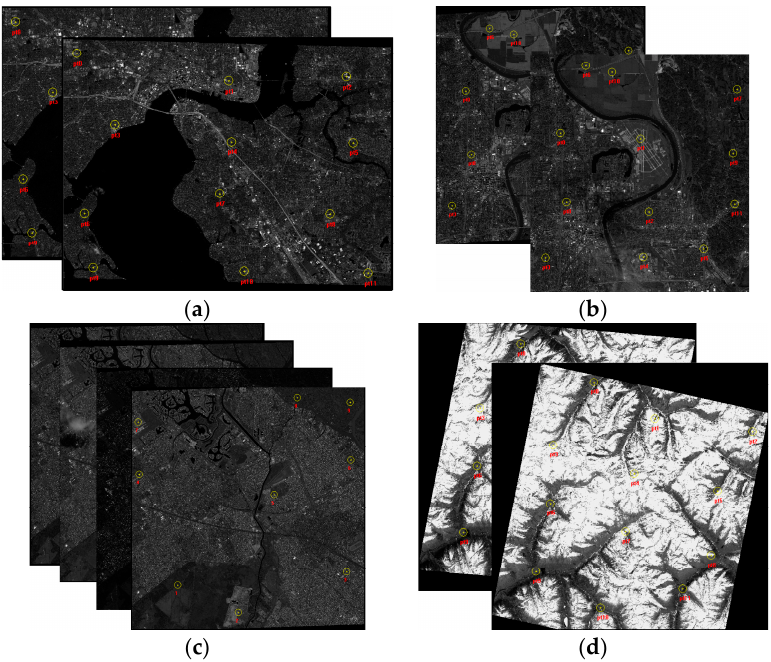
Figure 4. Experimental data. ( a ) WorldView-3 pair near Jacksonville. ( b ) WorldView-3 pair near Omaha. ( c ) WorldView-3 pairs near Buenos Aires. ( d ) Gaofen-7 pair near Tibet.